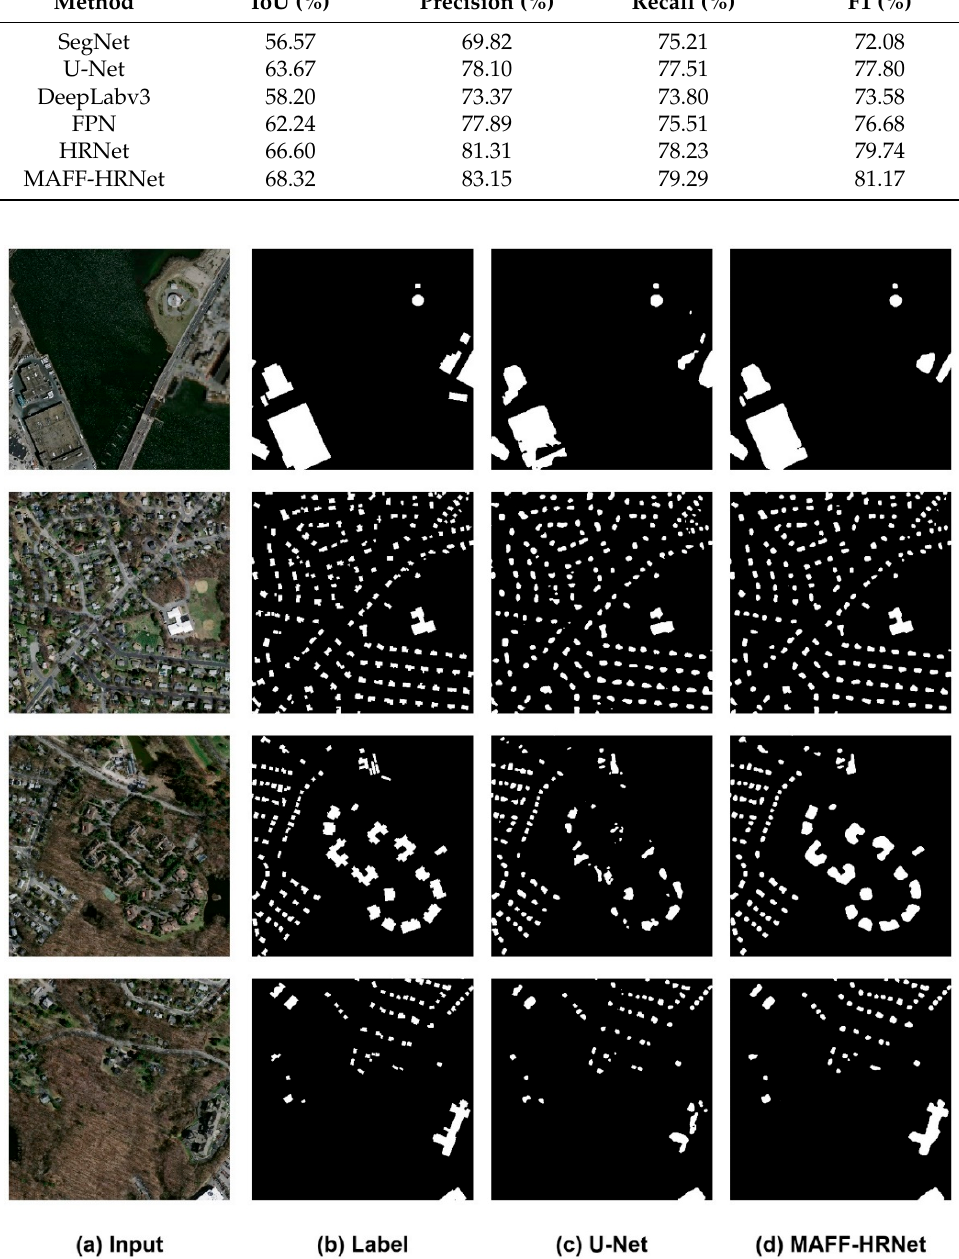
Figure 8. Experimental results on the Massachusetts Buildings Dataset. ( a ) Original images. ( b ) Im- age labels. ( c ) U-Net results. ( d ) Results of our model. labels. ( c ) U-Net results. ( d ) Results of our